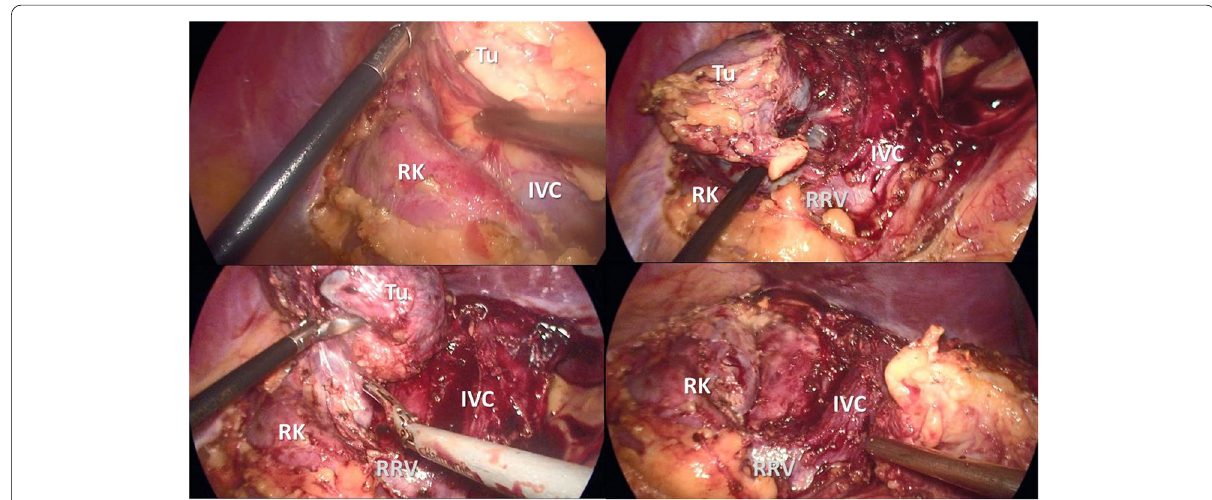
Fig. 3 Intraoperative view of the cystic lesion; RK—right kidney; IVC—inferior vena cava; Tu—tumor; RRV—right renal vein